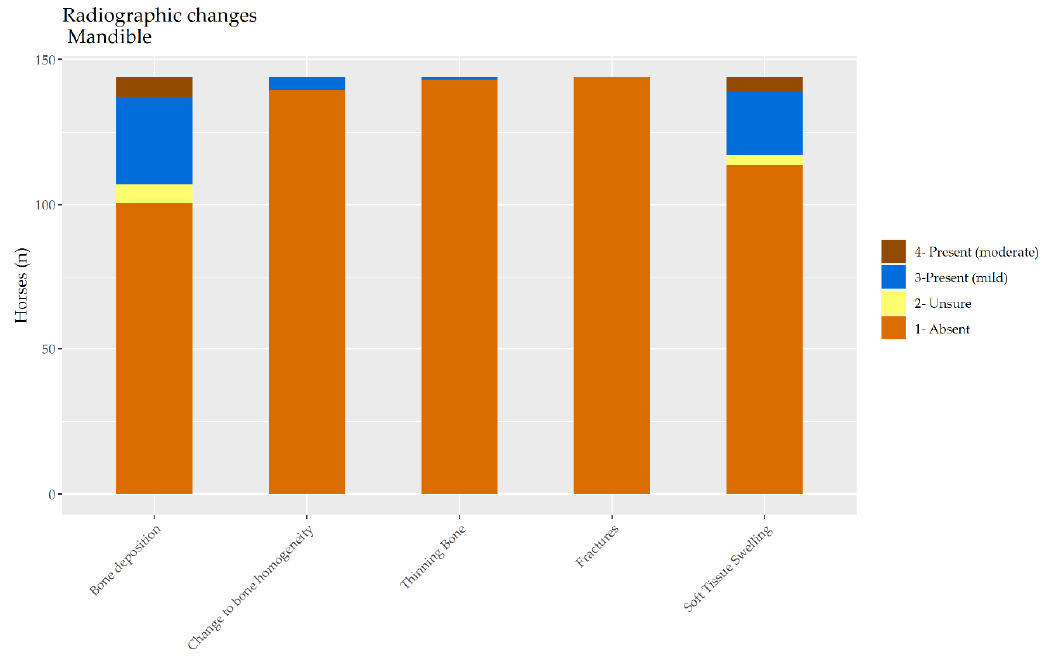
Figure 7. The distribution of radiological findings in the mandibles of a random selection of 144 cavalry horses.